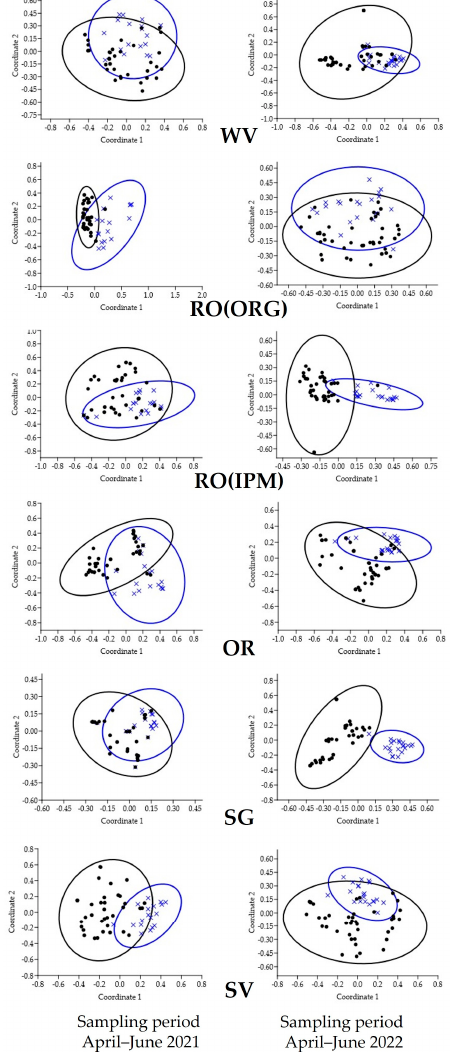
Figure 11. Principle Coordinate Analysis graphs showing the similarity between communities of natural enemies on fi eld margins (blue ellipses) and orange trees (black ellipses) in orchards with di ff erent fi eld margin management: WV—weed vegetation; RO(ORG)—rosemary hedgerow (or- ganic orchard); RO(IPM)—rosemary hedgerow (IPM orchard); OR—oregano hedgerow; SG—sage hedgerow; SV—savory hedgerow.